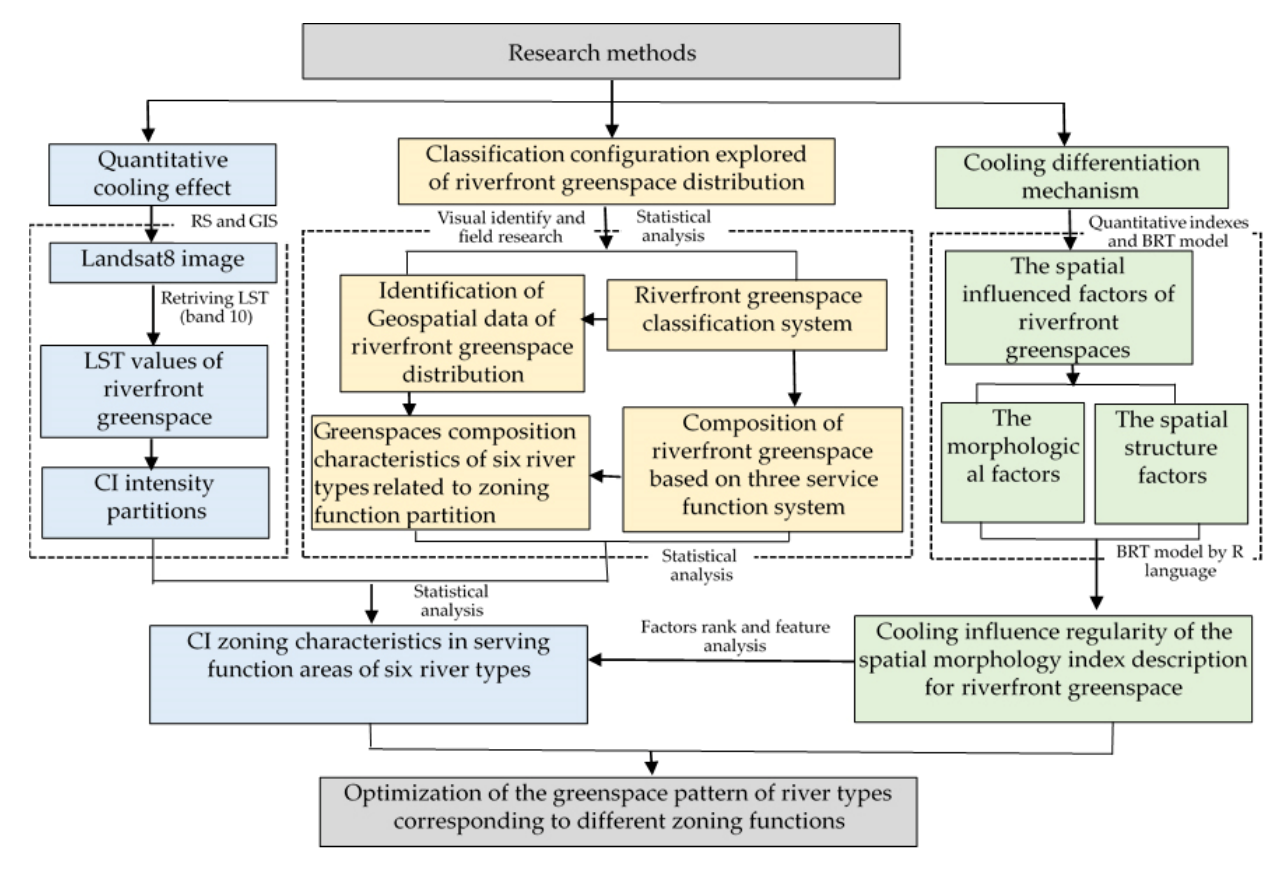
Figure 2. Framework flowchart of the study.